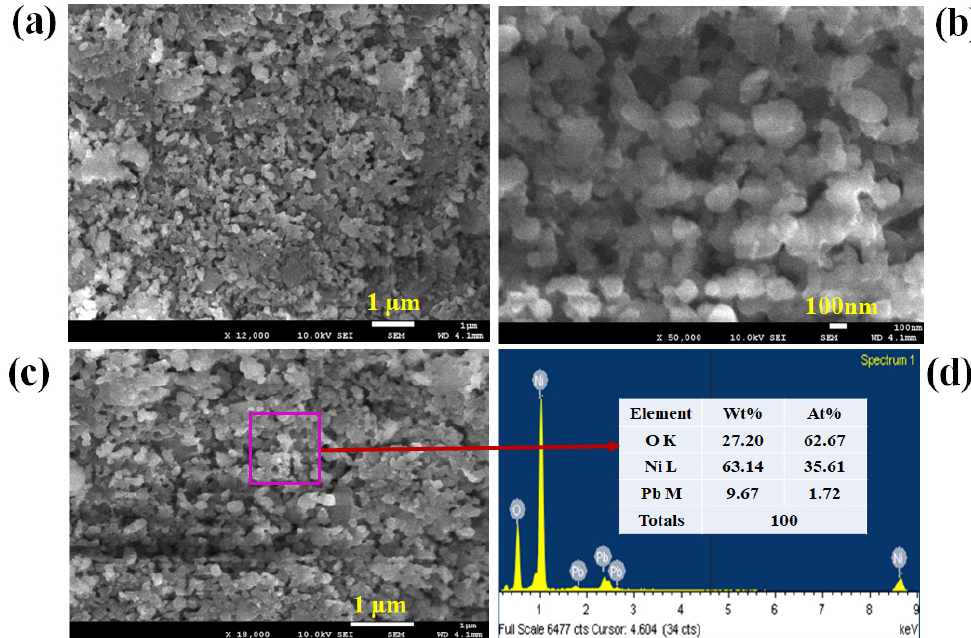
Figure 1. FESEM and EDS investigation of PbO/NiO nanomaterials. ( a , b ) Low and high magnifica- tion images of prepared PbO/NiO nanomaterials obtained from FESEM, ( c ) the magnified image of PbO/NiO nanomaterials from EDS analysis, and ( d ) atomic composition PbO/NiO NCs.